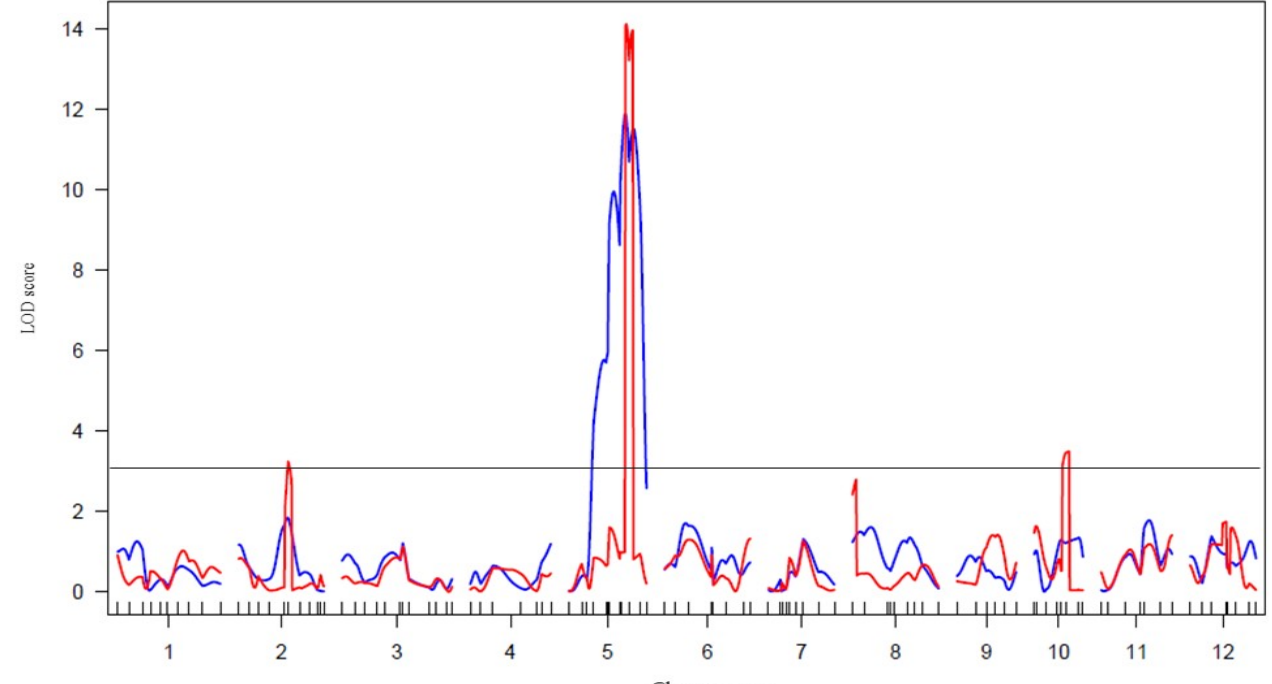
Figure 3. Plotting of LOD scores for QTL analysis at 99% tile threshold using “hk” regression method. The blue line data were calculated using simple interval mapping (SIM). The red line data show calculated LOD using a composite interval mapping (CIM) approach with stepwise covariate addition within the regression model.